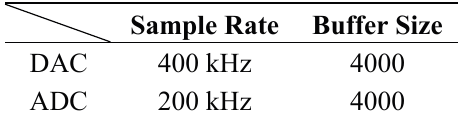
Table 4. Configuration of sampling parameters.